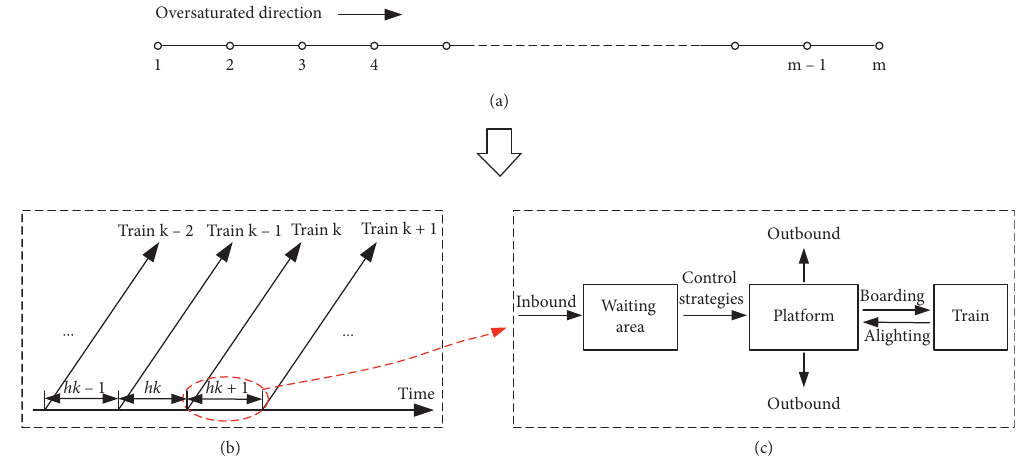
Figure 1: Urban rail line with heterogeneous headways and control strategies: (a) urban rail line; (b) train headways; (c) passenger flow